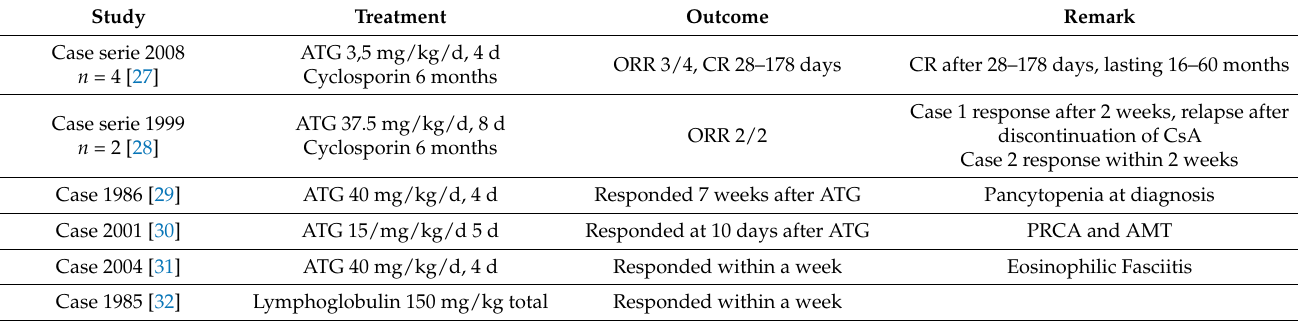
Table 4. Published studies on ATG as treatment in acquired amegakaryocytic thrombocytopenia. d: days, ORR: overall response rate, CR: complete